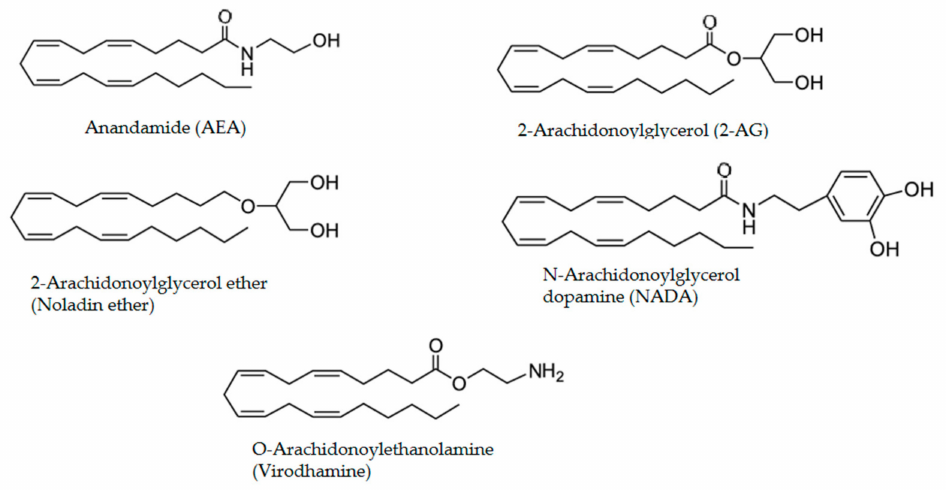
Figure 2. Chemical structures of the endocannabinoids. AEA and 2-AG are lipophilic molecules and are synthesized de novo by cleavage of their membrane lipid precursors N -arachidonoyl-phosphatidylethanolamine ( N -ArPE) and sn -1-acyl-2-arachidonoylglycerols (DAGs) respectively [26]. The enzymes N -acyl- phosphatidylethanolamine-selective phospholipase D (NAPE-PLD) and diacylglycerol lipase (DAGL) biosynthesise AEA and 2-AG, respectively; the enzymes fatty acid amide hydrolase (FAAH) and the monoacylglycerol lipases (MAGL) are involved in the degrada- tion of AEA and 2-AG, respectively [27]. These enzymes, together with CB receptors and eCBs, are key components in the eCB system. AEA, named anadamide after the Sanskrit word ananda or “bliss”, was discovered in 1992 and functions as a partial agonist at